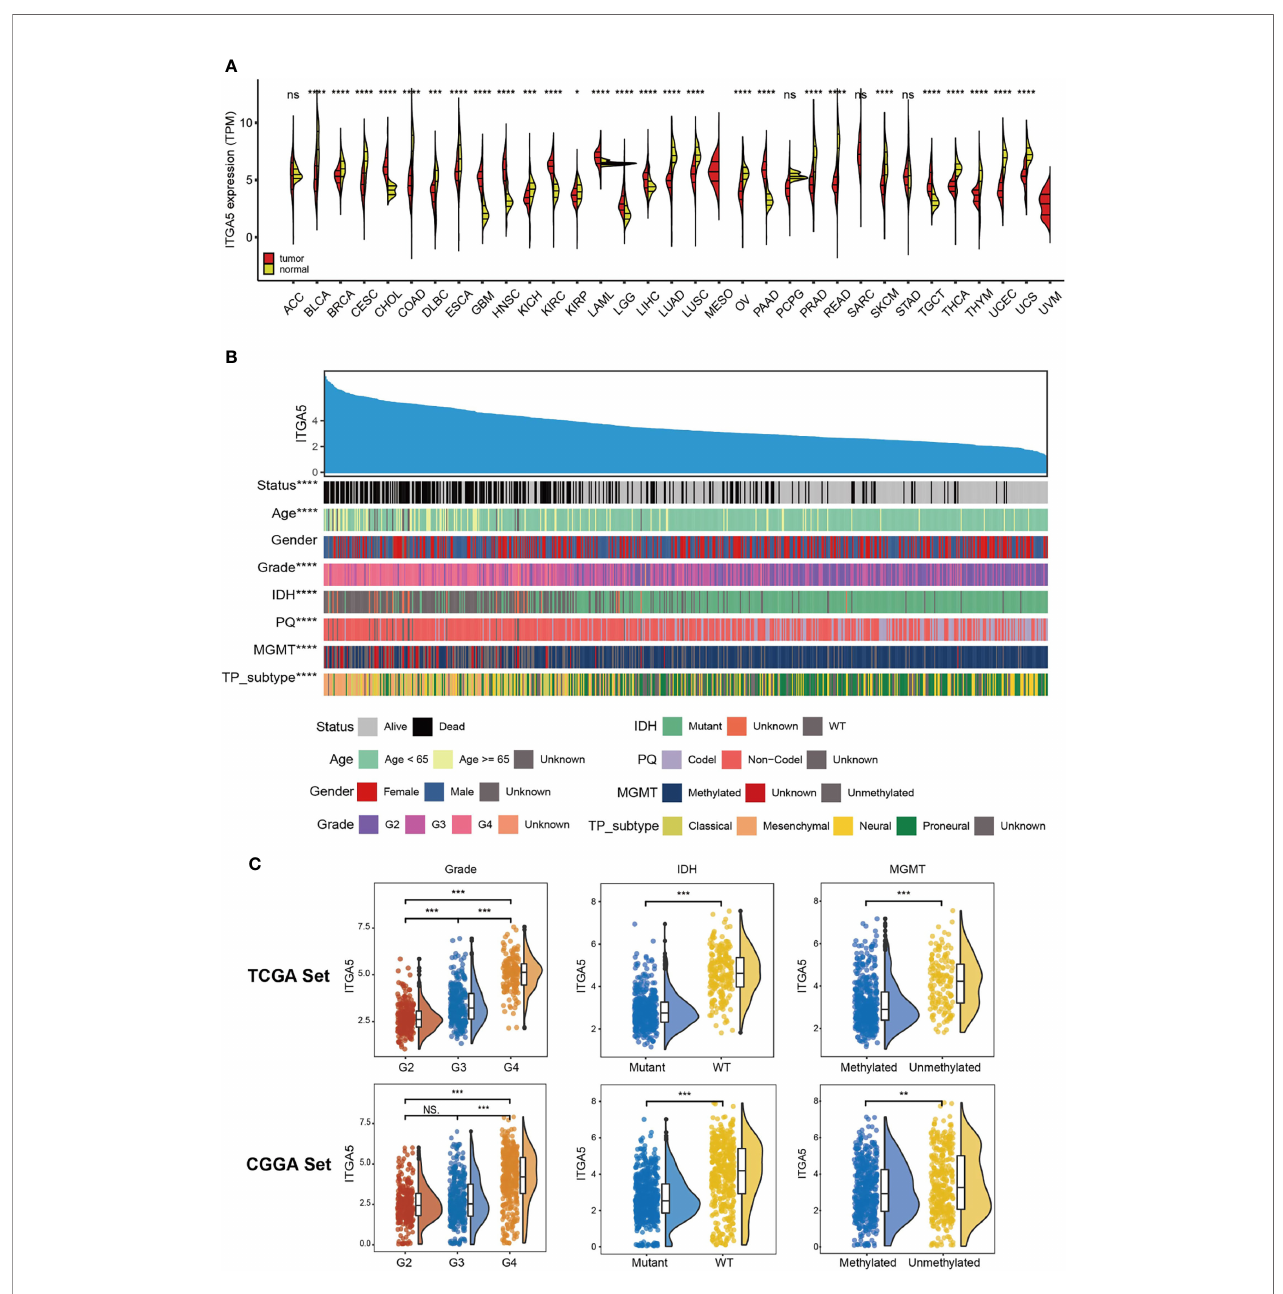
FIGURE 1 | The clinical and molecular characteristics in associations with ITGA5 expression. (A) ITGA5 levels among pan-cancer samples grouped by cancer and normal status from TCGA and GTEx. (B) An overview of the association between known clinical and molecular features in TCGA, namely, status, age, gender, grade, IDH mutation, 1p/19q codeletion, MGMT methylation, and TP subtype. (C) The expression levels of ITGA5 in different WHO grades, IDH states and MGMT methylational states from the TCGA and the CGGA datasets. NS, not statistically signi fi cant, *P < 0.05, **P < 0.01, ***P < 0.001, ****P <